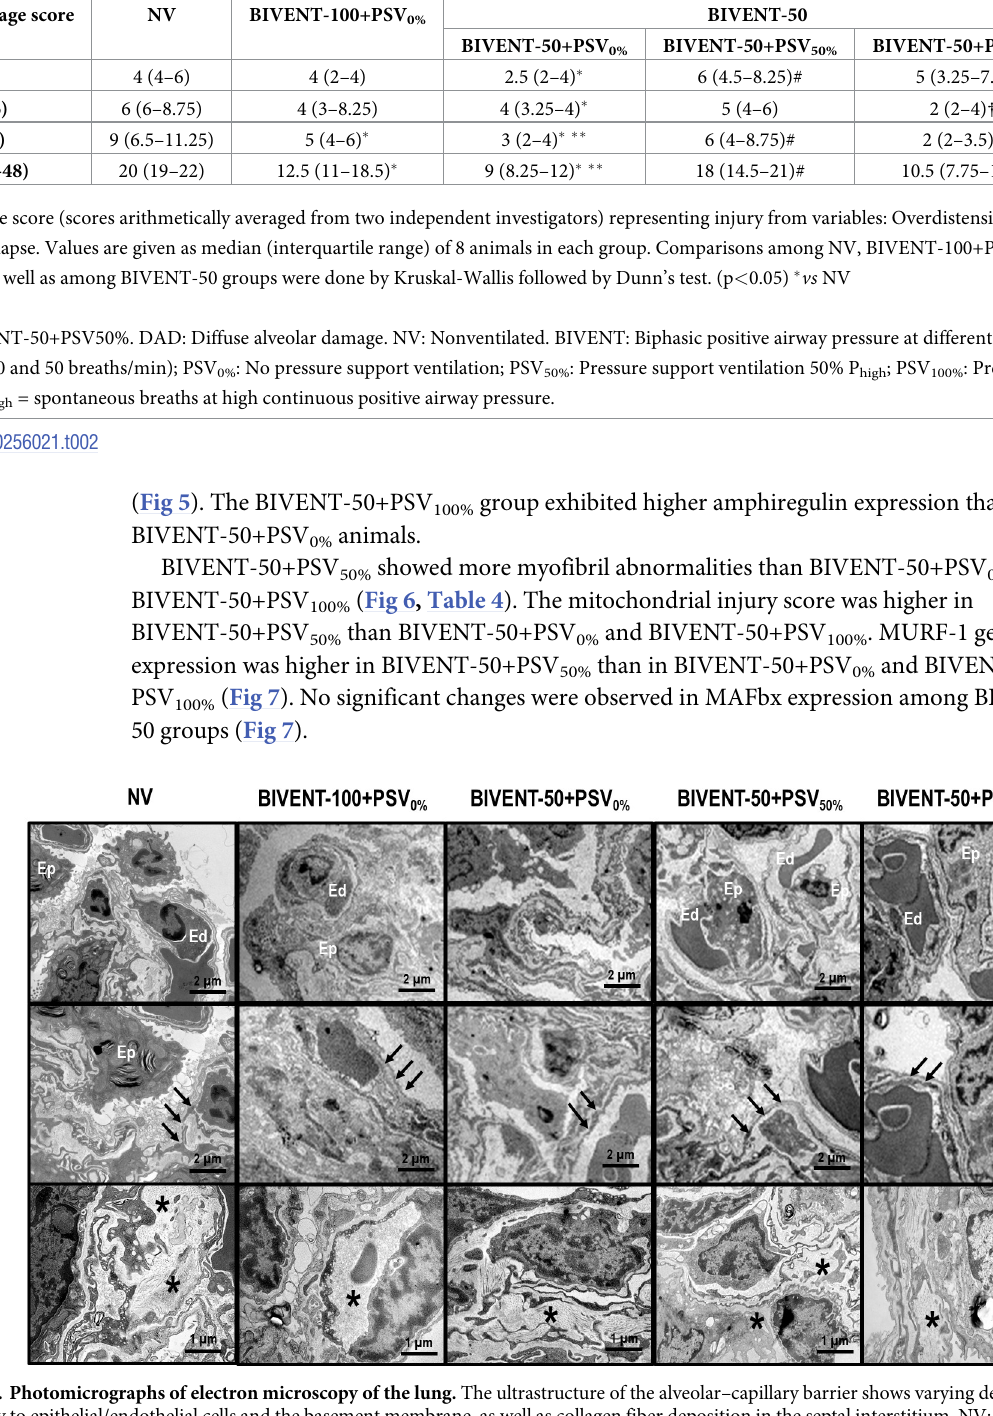
Fig 4. Photomicrographs of electron microscopy of the lung. The ultrastructure of the alveolar–capillary barrier shows varying degrees of injury to epithelial/endothelial cells and the basement membrane, as well as collagen fiber deposition in the septal interstitium. NV: Nonventilated. Note that BIVENT-50+PSV 50% induced more epithelial (Ep) and endothelial cell (Ed) apoptosis, irregularity and thickness of the basement membrane (arrows), and collagen fiber deposition ( � ) in the alveolar-capillary barrier than BIVENT-50+PSV 0% . In contrast, less epithelial (Ep) and endothelial cell (Ed) apoptosis, greater basement membrane integrity (arrows), and less collagen fiber deposition ( � ) can be seen in BIVENT-50+PSV 100% compared to BIVENT-50+PSV 50%